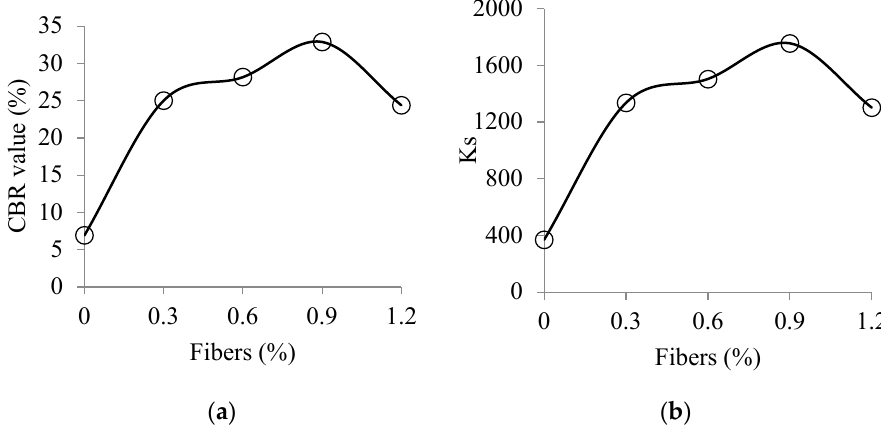
Figure 13. Effect of fiber addition on CBR value ( a ) and Secant modulus ( b ).